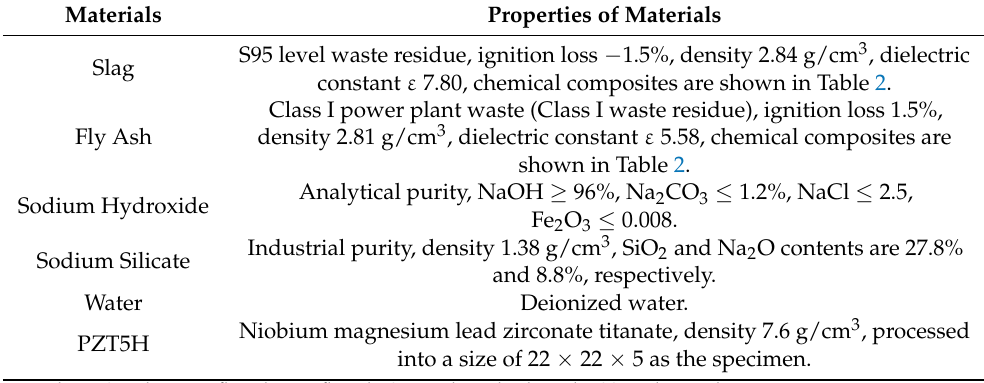
Table 1. Material properties.